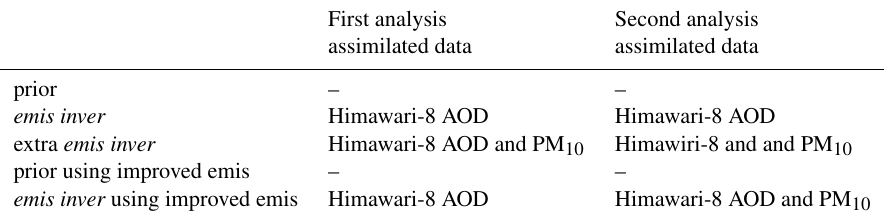
Table 2. Dust storm emission inversions.